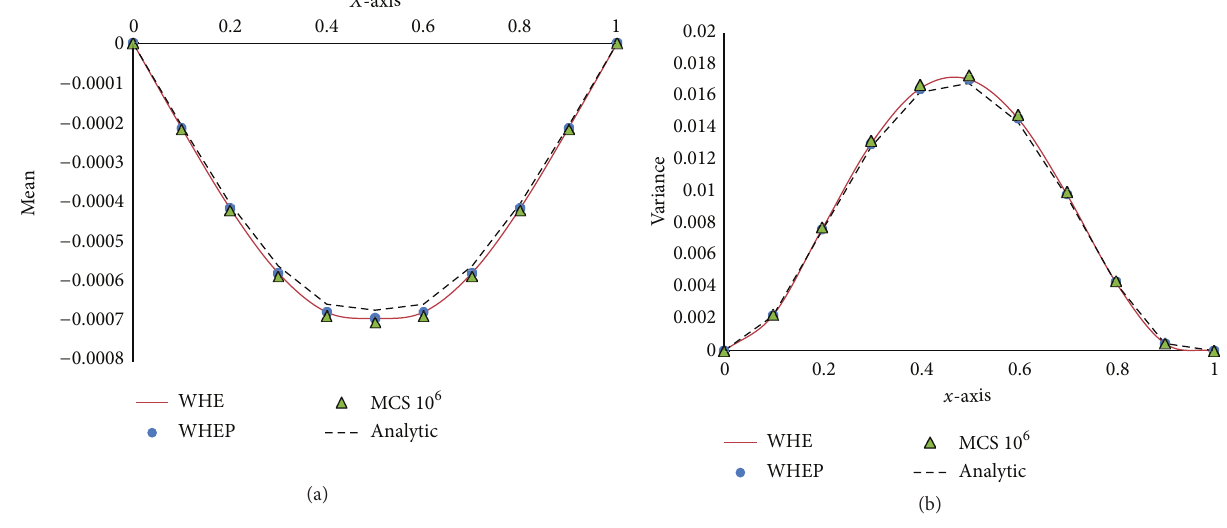
Figure 1: Steady-state mean (a) and variance (b) along 𝑥 -axis for 𝜆 = 0.5 using the four different